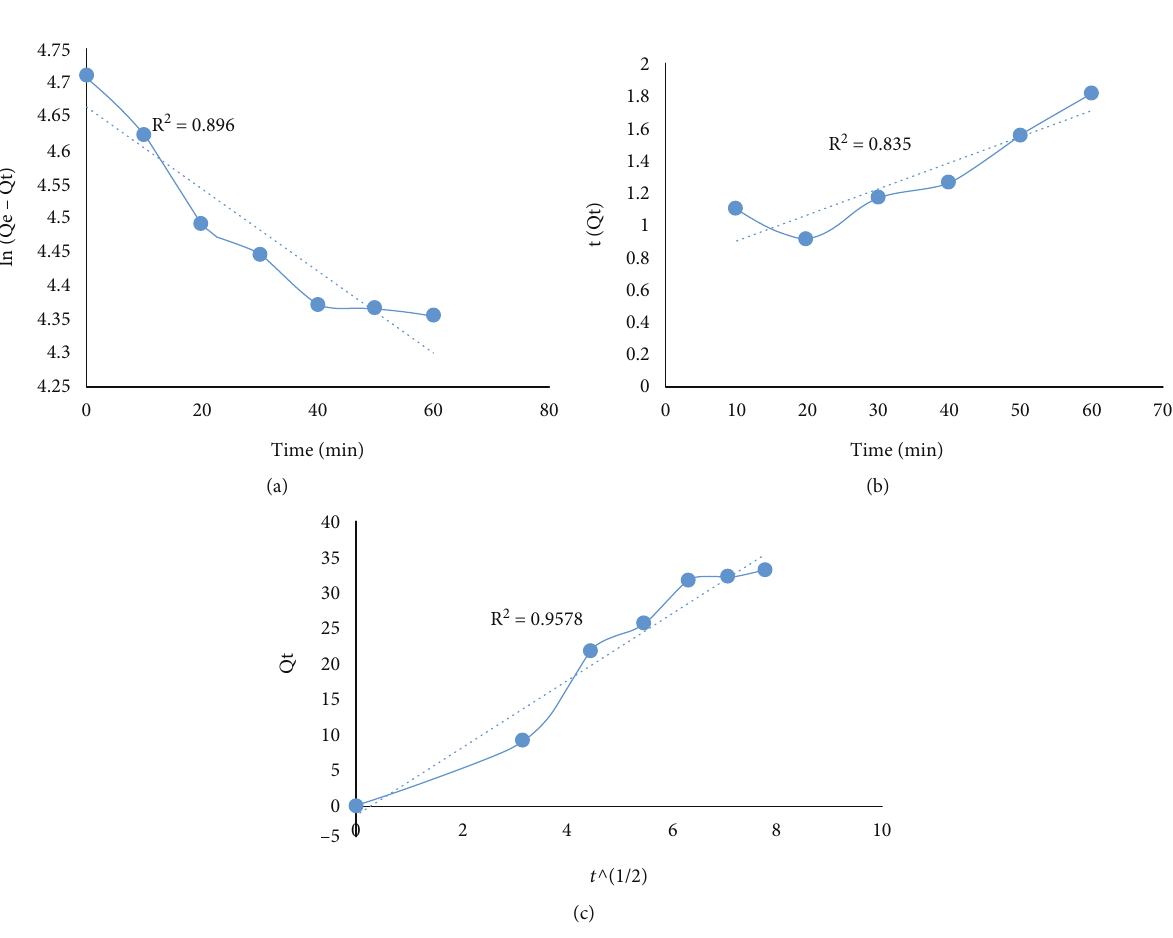
Figure 10: (a) Pseudo- fi rst-order, (b) pseudo-second-order, and (c) intraparticle di ff usion study of methyl red removal by MGP. Table 3: Kinetic parameters for methyl red removal by